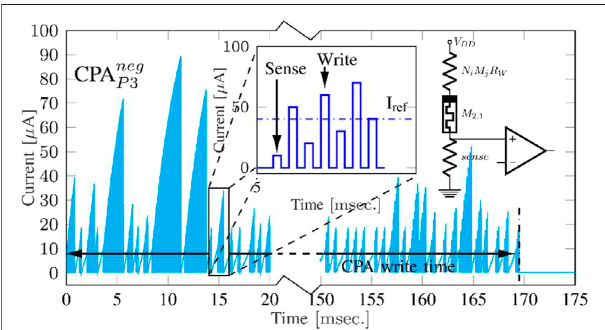
FIGURE 6 | Sensed output current for a SLP partition (one small CPA) duringtheprogrammingphasefollowingaCLTscheme.Thegreaterthepeak, the higher the conductance level being programmed. For this scenario, NM-1 and 8partitionsper CPA wereconsidered. Theinsetinthecentreshows aschematicrepresentationofthecurrentmeasuredduringtheverifyandwrite pulsesaswellasthecurrenttarget.Theinsetintherightshowsaschematicof the equivalent circuit used during the verify